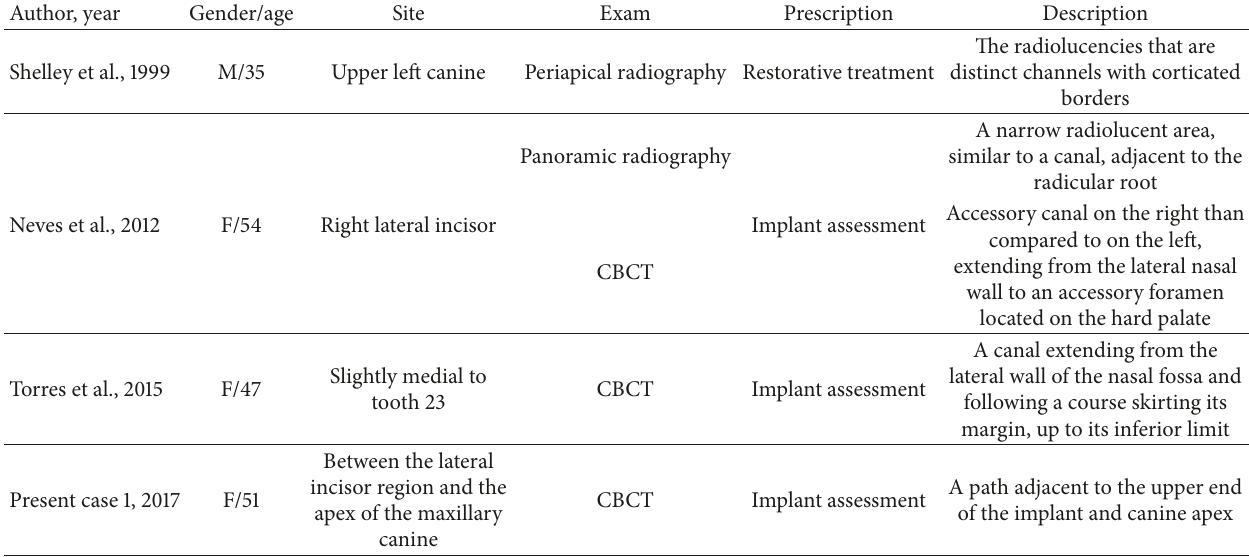
Table 1: Data of cases of the canalis sinuosus published in PubMed-Medline from 1999 to